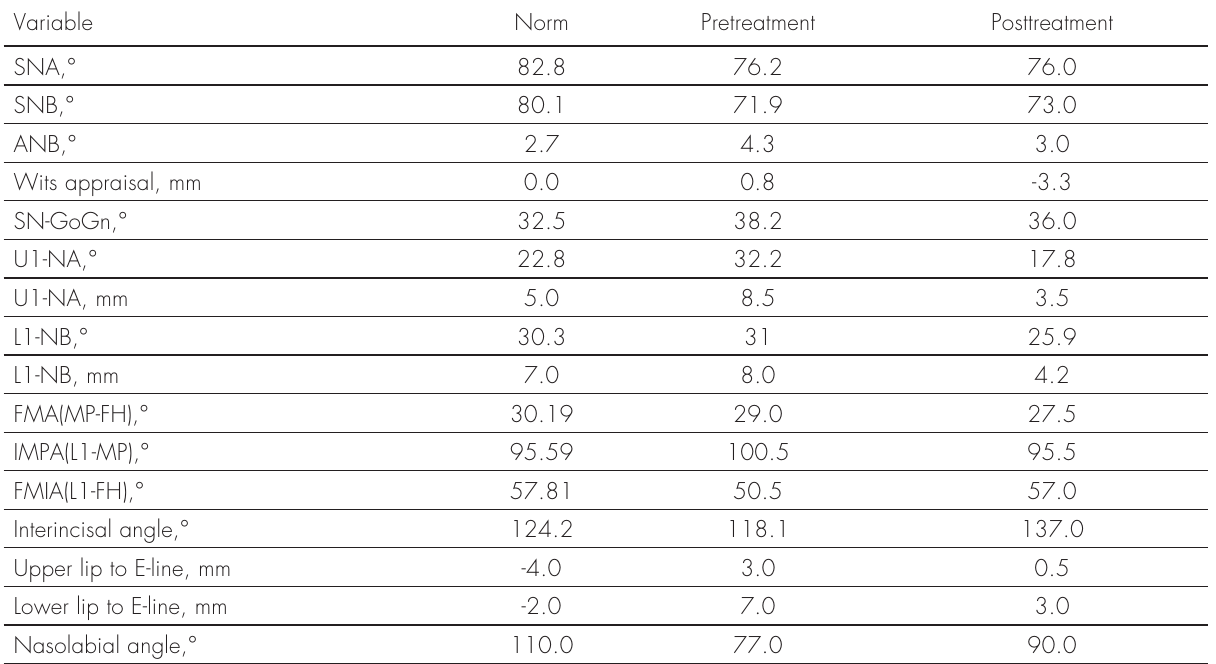
Table I. Cephalometric